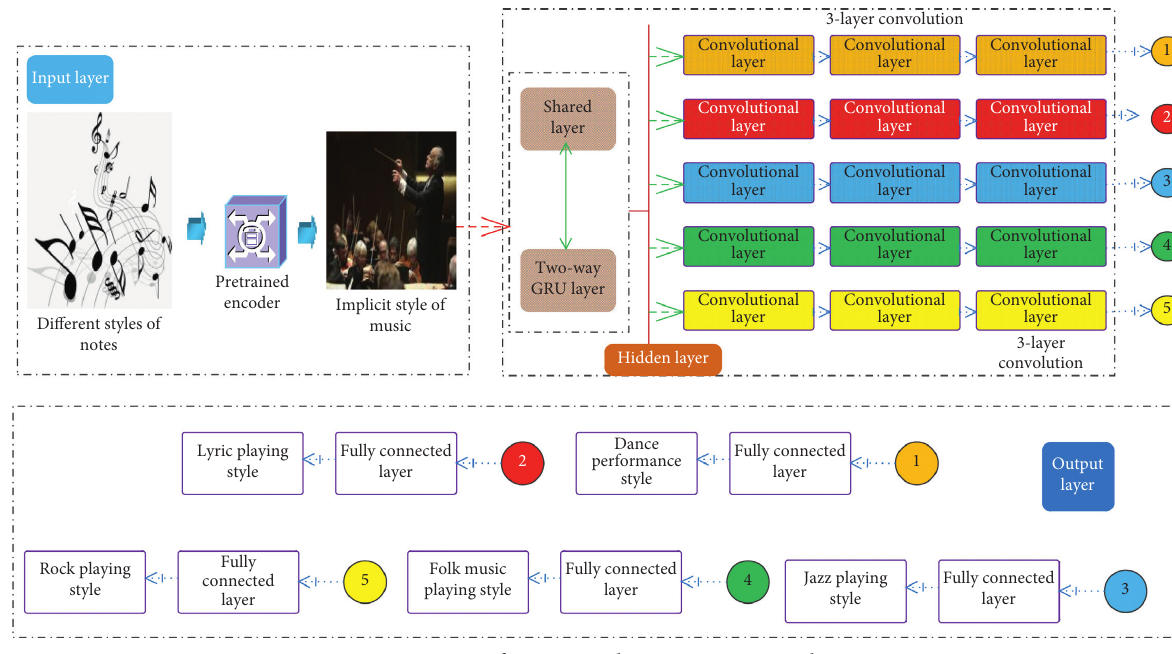
Figure 3: Performance style conversion